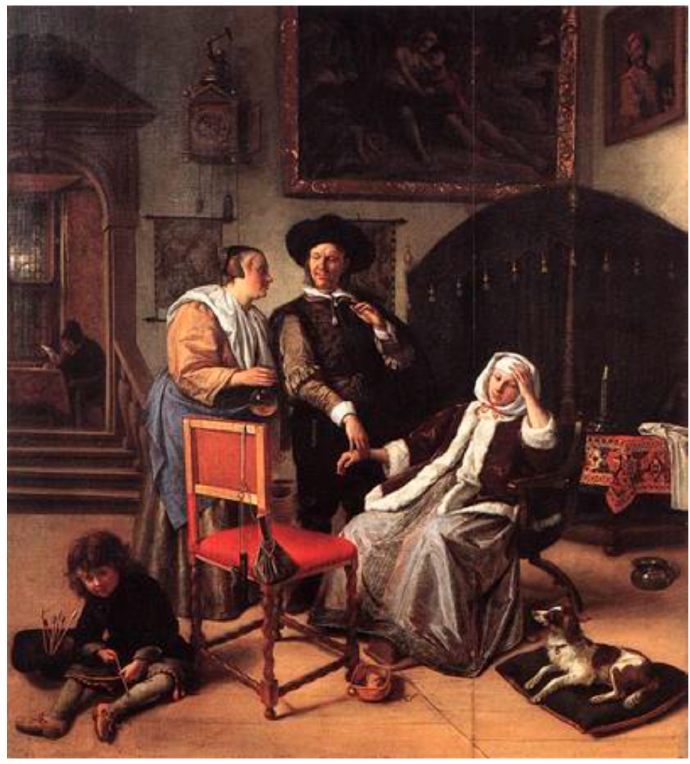
Figure 3. “The Doctor’s Visit” by Jan Steen, 1661–1662, Victoria and Albert Museum, London.